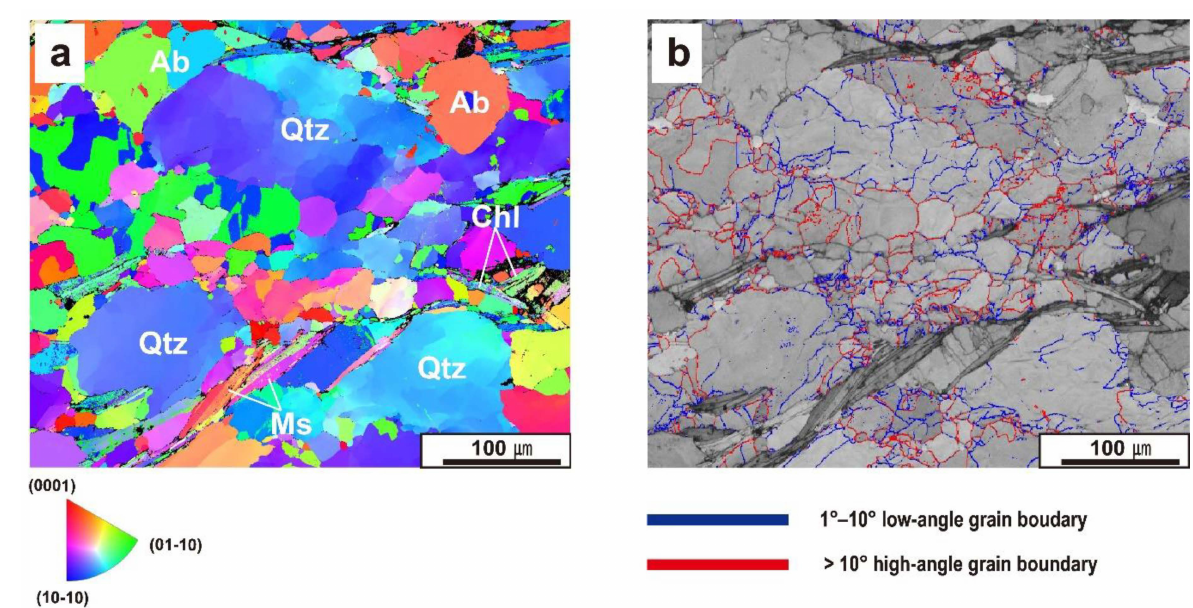
Figure 4. Magnified EBSD maps of sample G105 (Yellow box in Figure 3a). ( a ) Inverse pole figure showing crystallographic axes aligned parallel to the lineation. Quartz grains have subgrain boundaries, indicating intracrystalline plastic deformation, while albite rarely show microstructures of ductile deformation. ( b ) Low-angle (1 ◦ –10 ◦ ) and high-angle (<10 ◦ ) grain boundary map of quartz on the band contrast map. Note that grain boundaries of albite were